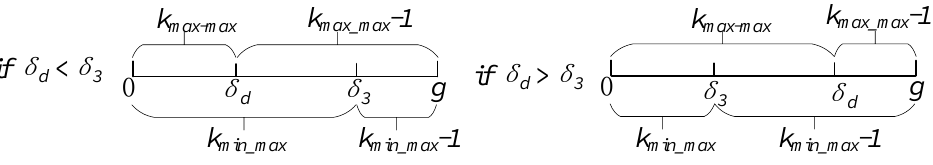
Figure 5. The variation of k max _ max and k min _ max with respect to ε 0